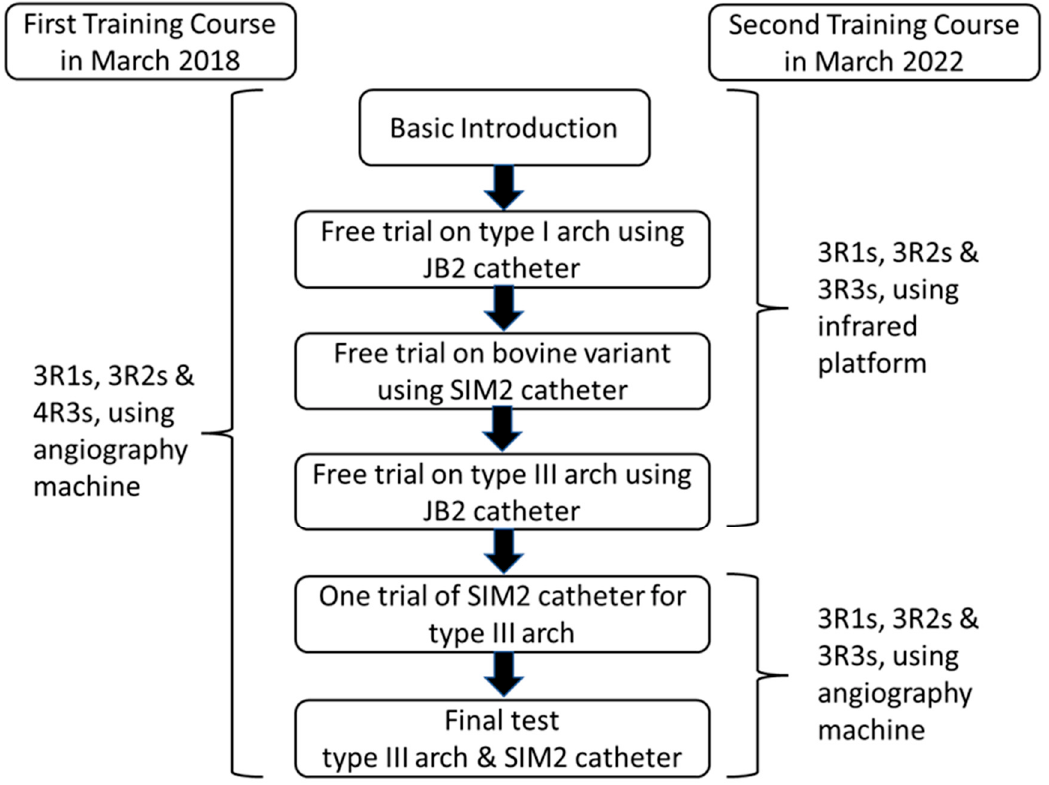
Figure 5. Process of the first and second training courses.